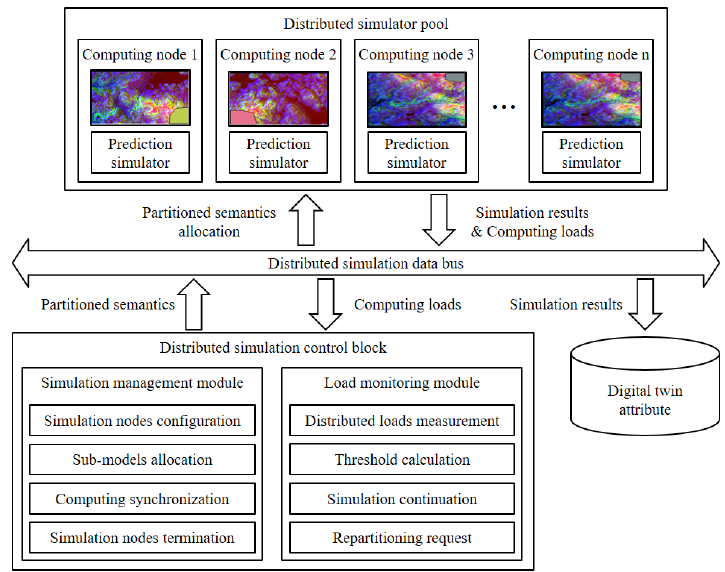
Figure 8. The simulation control block manages the distributed computing